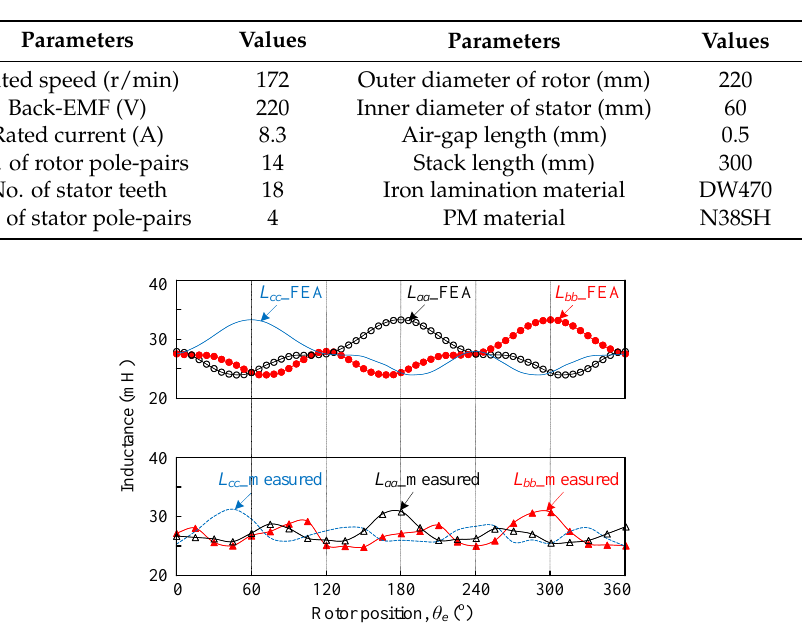
( b ) Figure 12. Back-EMF waveforms at the rated speed. ( a ) Finite element analysis (FEA) results; and ( b ) experimental results (100 V/div). Based on the aforementioned modeling analysis, the vector-control strategy can be applied for the prototype machine. Figure 13a shows the variations of output torque and speed with sudden increased load from 115 Nm to 180 Nm at the rated speed 172 r/min, and the corresponding variations of the three-phase current are given in Figure 13b. It can be seen that the output torque can rapidly track the load changes, and the torque ripples at steady state are always very low.